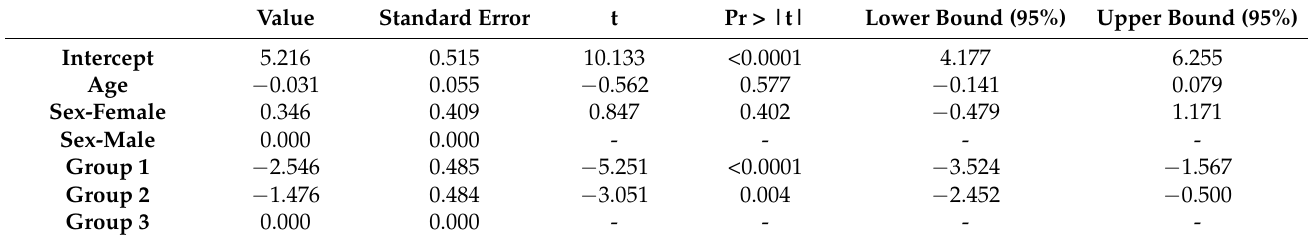
Table 4. Model parameters and